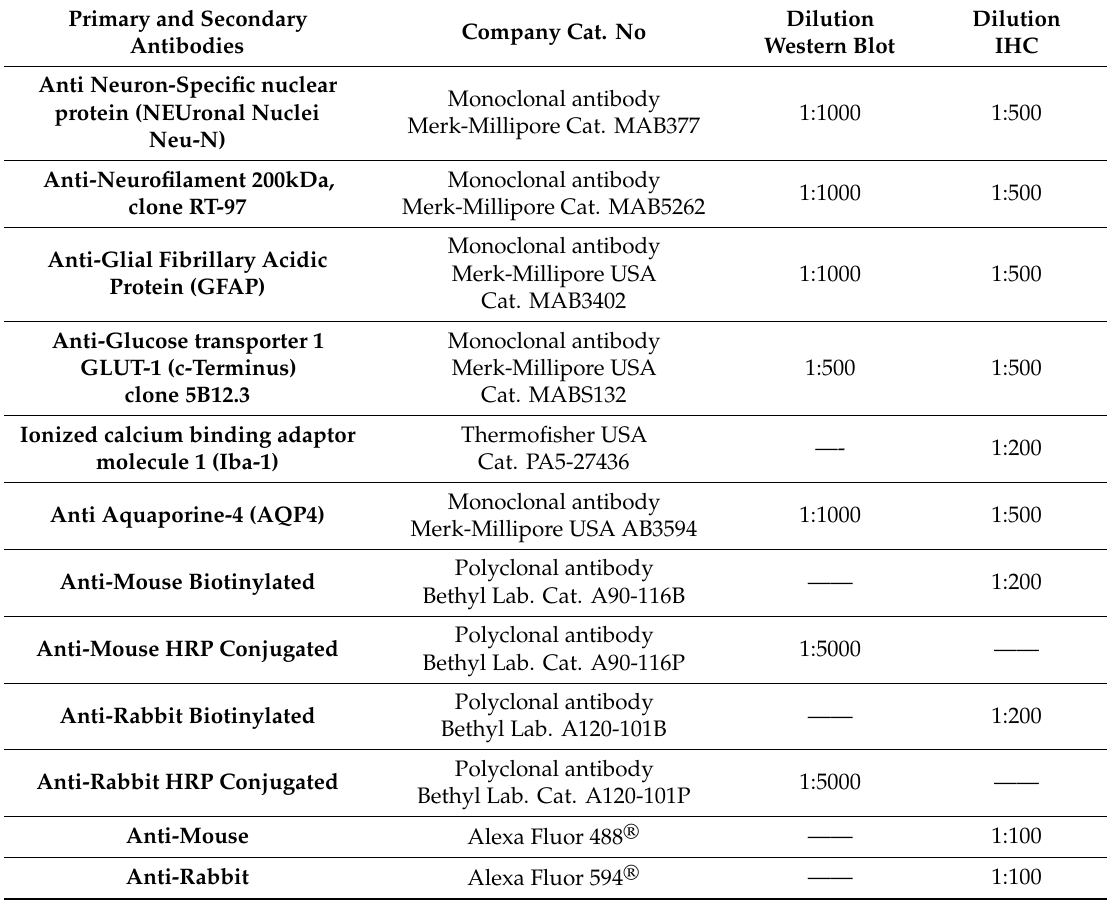
Table 1. Primary and Secondary antibodies used in Western blot and immunohistochemistry (IHC). Primary and Secondary